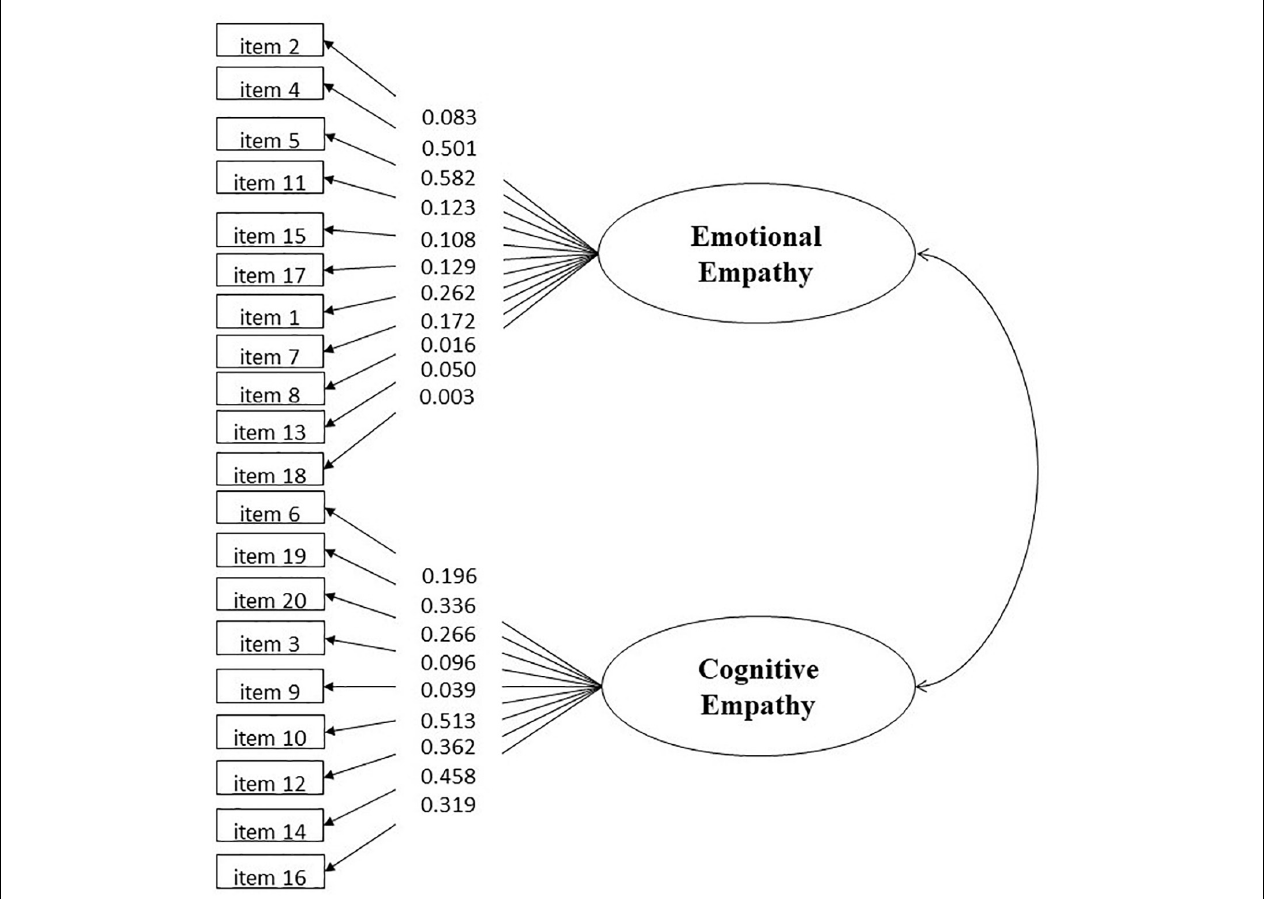
FIGURE 1 | Two factors model with methodological